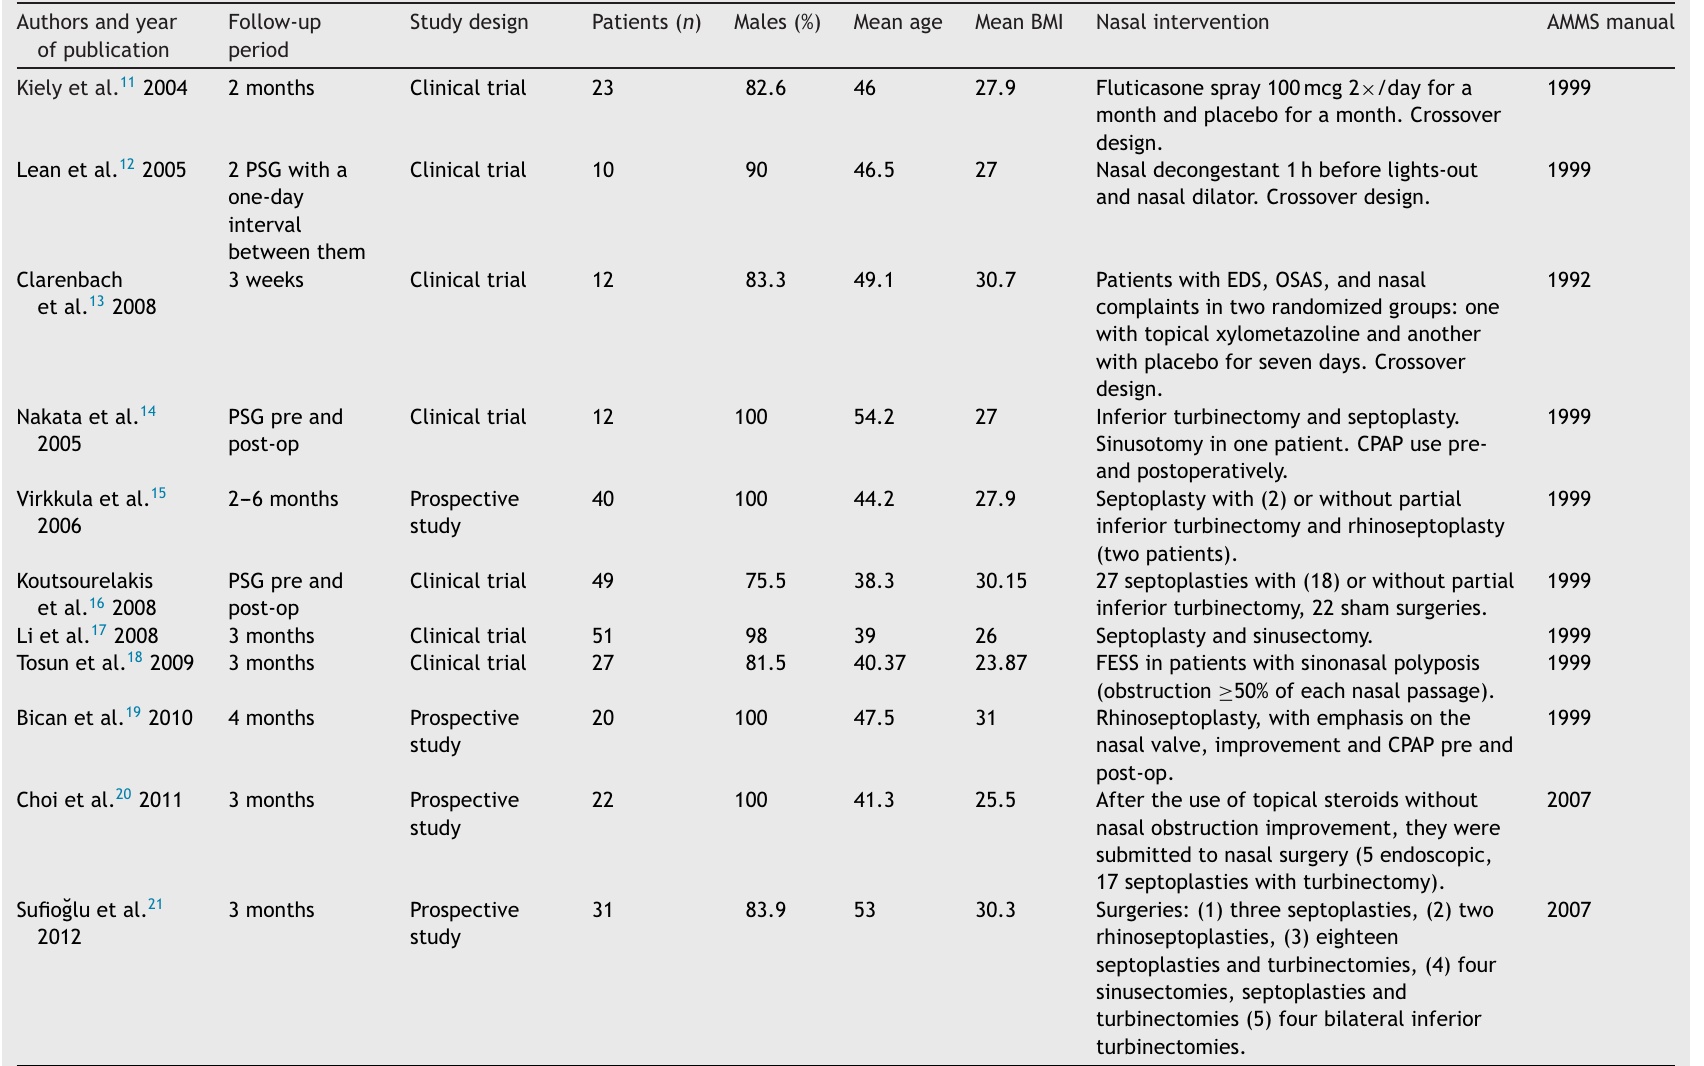
Table 1 Total number of studies with clinical and surgical